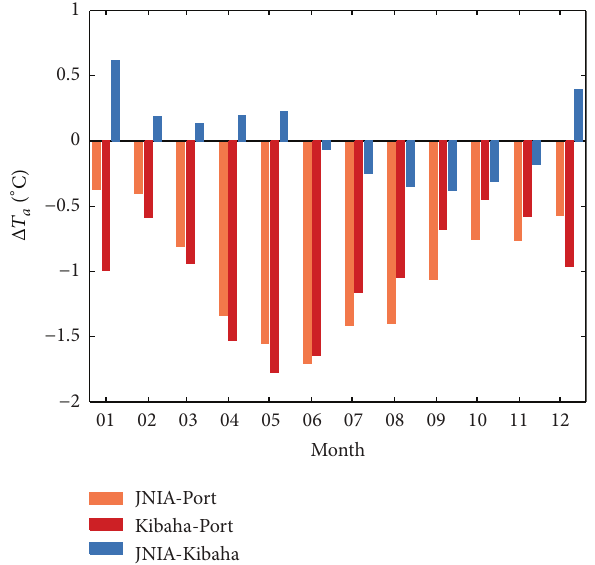
Figure 2: Intraurban air temperature differences as depicted by the long-term mean monthly differences between the three weather